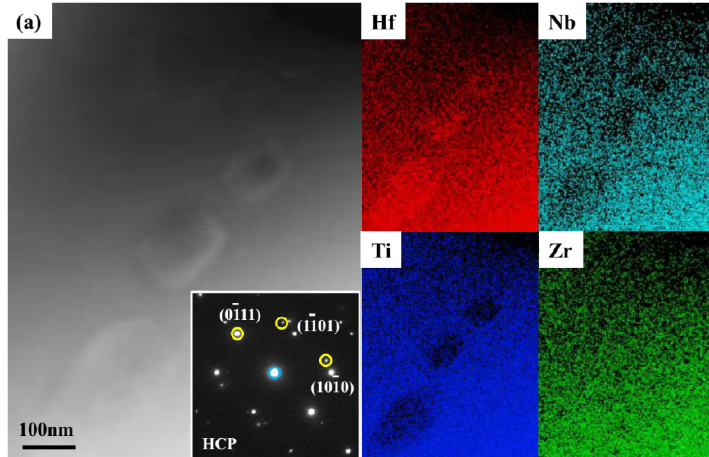
Figure 2. High-angle annular dark field scanning transmission electron microscopy (HAADF -STEM) image and energy-dispersive spectroscopy (EDS) maps of 1073 K-annealed RHEA. The illustration is a selective electron diffraction pattern of the hcp phase. The Hf-rich, (Ti,Nb)-depleted areas correspond to the hcp precipitates.